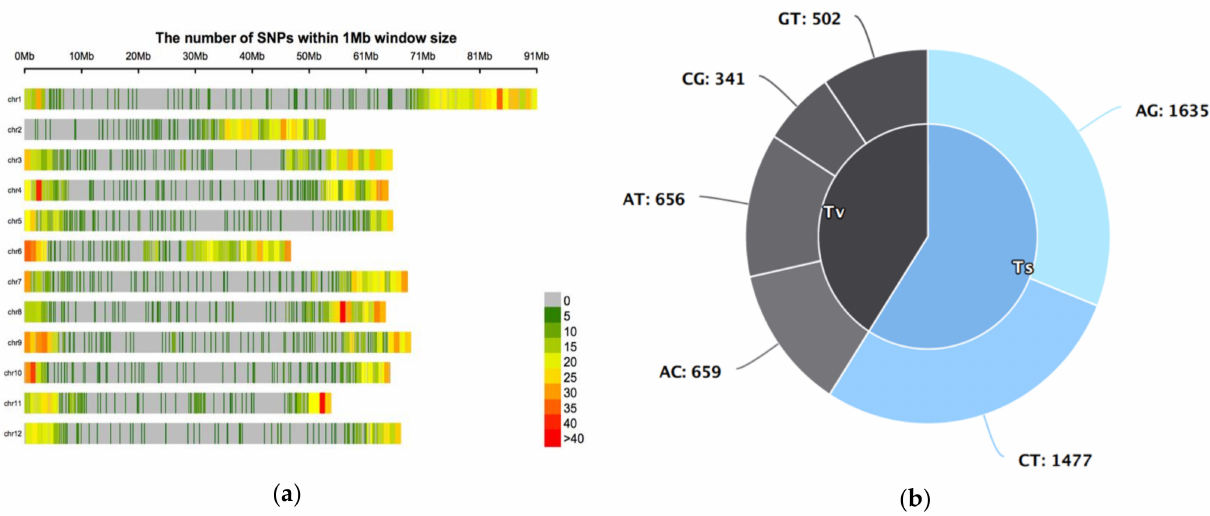
Figure 3. ( a ) Genome-wide single-nucleotide polymorphism (SNP) distributions and density of 5270 SNPs detected by DArTseq on the 12 chromosomes; ( b ) types of 5270 SNPs mutations detected by DArTseq of 43 S. lycopersicum and S. pimpinellifolium inbred lines and accessions on the 12